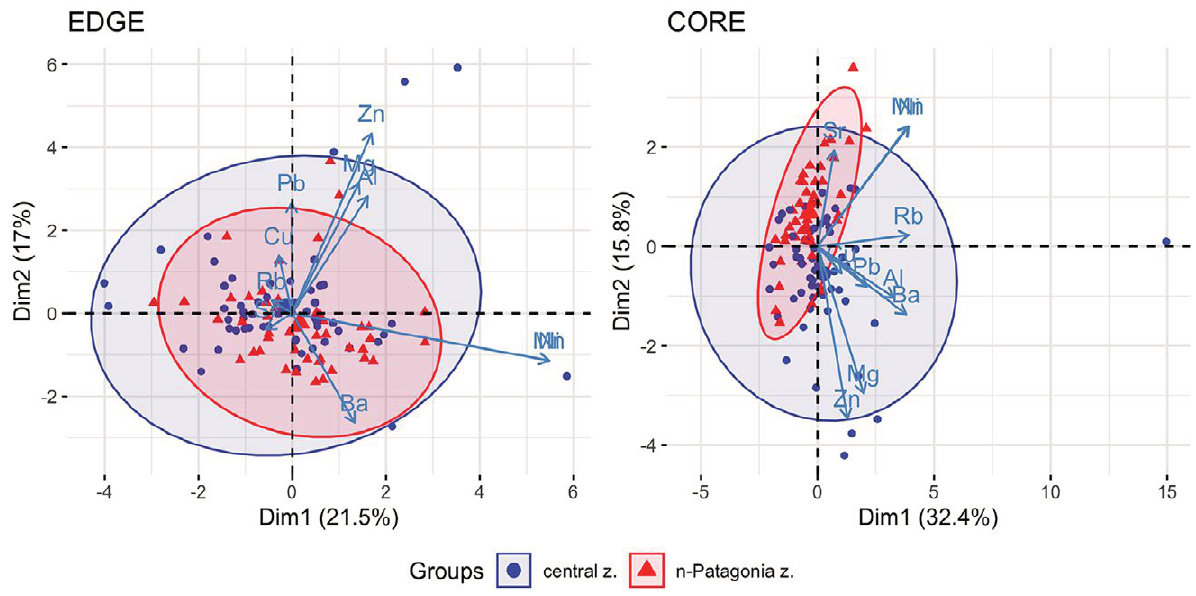
Fig. 4. – Principal component analysis ordination model of the otolith cores and edges with superimposed vectors of the element/calcium ratios. Element codes: Mg, magnesium; Zn, zinc; Pb, lead; Ba, barium; Sr, strontium; Al, aluminium; Mn, manganese; Ni, nickel; Cu, copper; Rb, rubidium. Symbols identify the place of